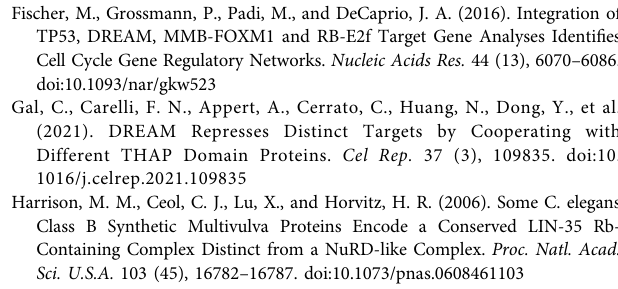
Supplementary Figure S2 | CNV correlation with mRNA expression. (A) The homozygous CNV pro fi le shows the percentage of homozygous CNV. (B) The associationbetweenpairedmRNAexpressionandCNVpercentageinsampleswas based on a Person ’ s product moment correlation coef fi cient. The size of the point represents the statistical signi fi cance, where the bigger the dot size, the higher the statistical signi fi cance. FDR, false discovery